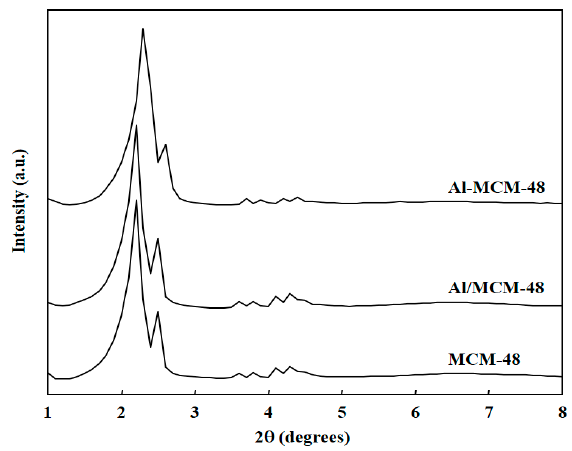
Figure 1. X-ray di ff raction (XRD) patterns of various samples after calcination at 823 K for 4 Figure 1. X-ray diffraction (XRD) patterns of various samples after calcination at 823 K for 4 h.